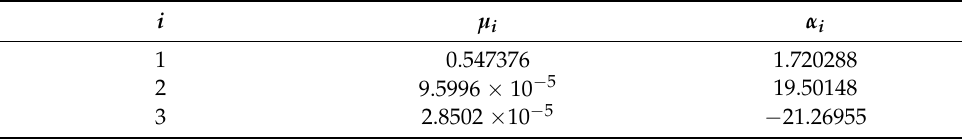
Figure 7. ( a ) The test data of reaction force vs. compressive displacement of the solid tire and the related simulation data obtained by the third-order Ogden hyperelastic model, and ( b ) the UT and BT test data and the related fitting data by the third-order Ogden hyperelastic model. Table 2. The material parameters in the third-order Ogden model.